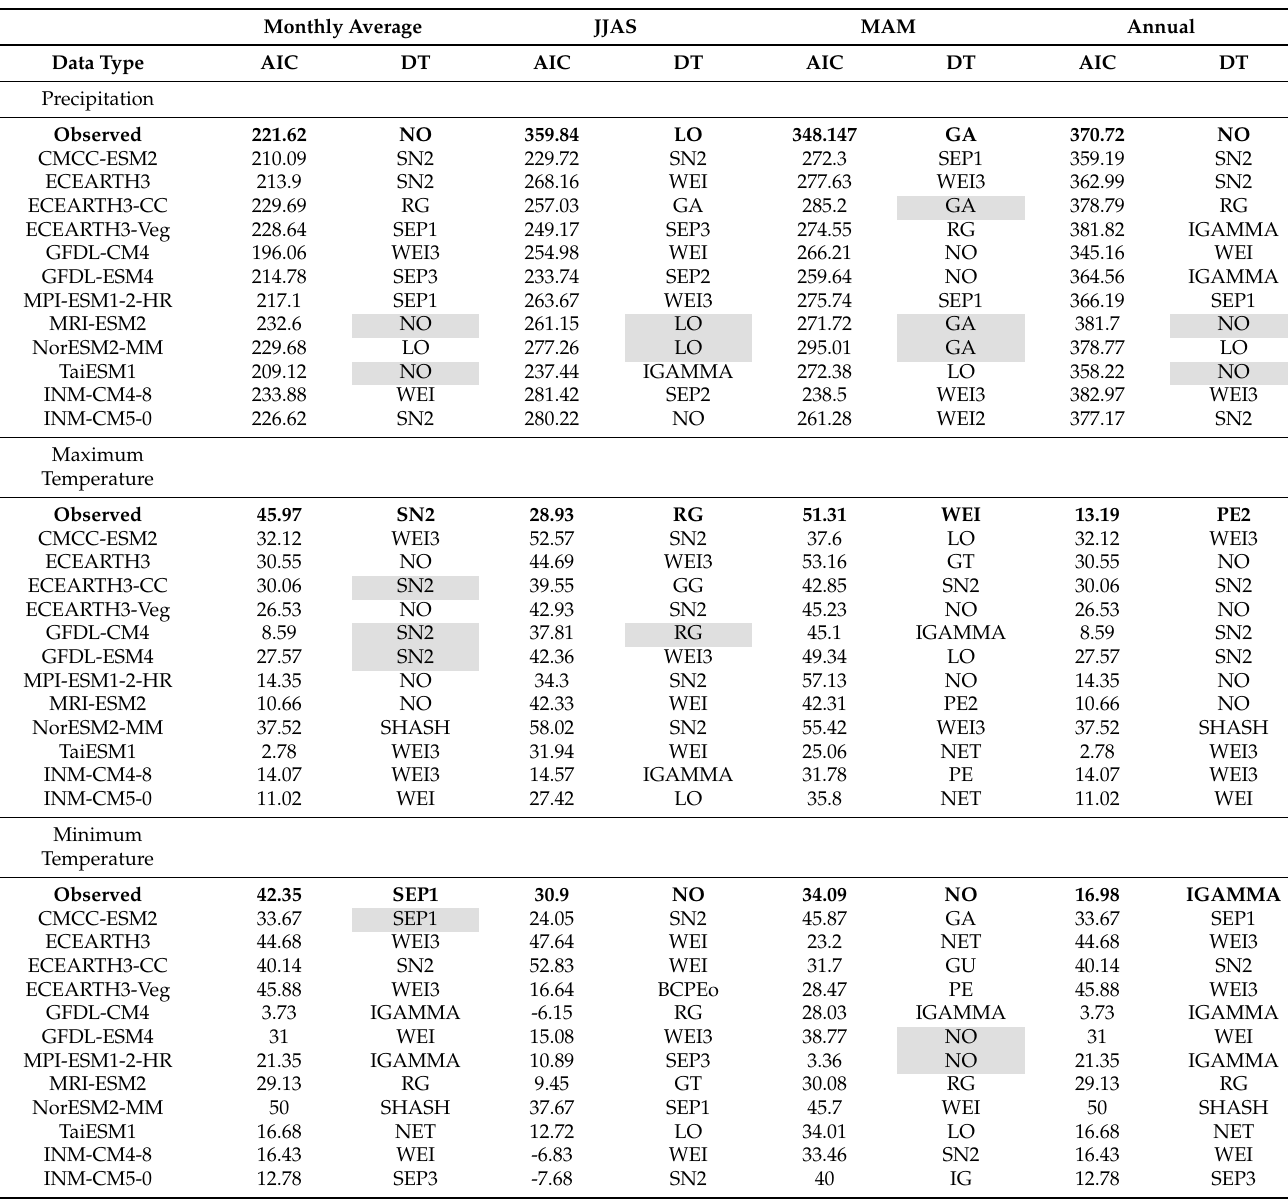
NB: highlighted in grey are models that shared the same distribution as the observed time series across each time period of the analysis. DT = distribution